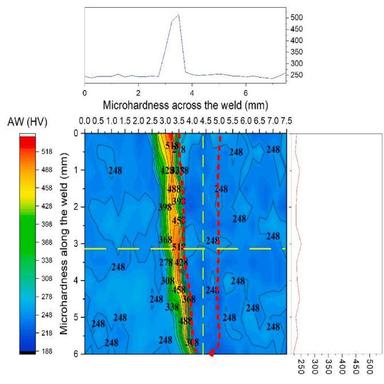
2D Microhardness contour profile plot of AW specimen.